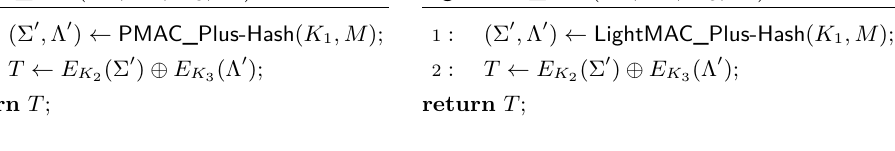
Figure 5.3: Algorithm for PMAC_Plus and LightMAC_Plus